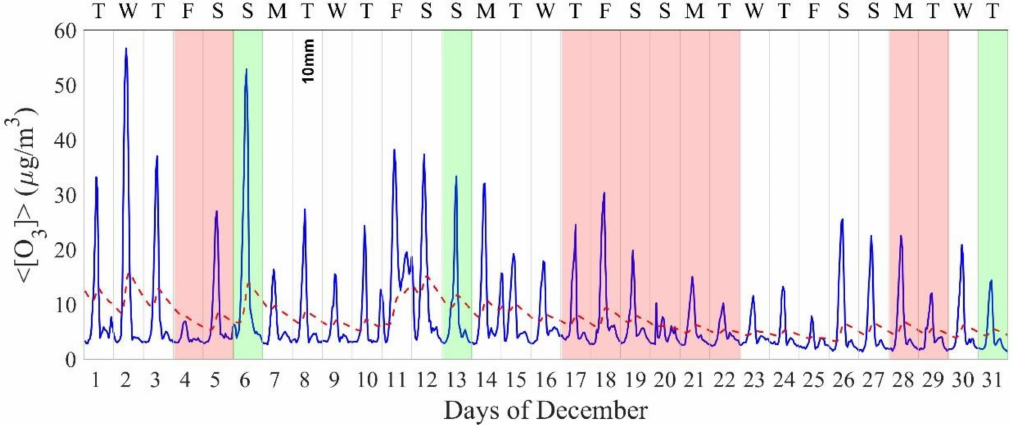
Figure 13. Oxone concentration variation related to the total block of urban traffic (green band) and alternated plates (red band) of December 2015. The blue line is the hourly pollutant concentration. The red dashed line is the daily mean pollutant concentration. Data of daily precipitation are indicated in